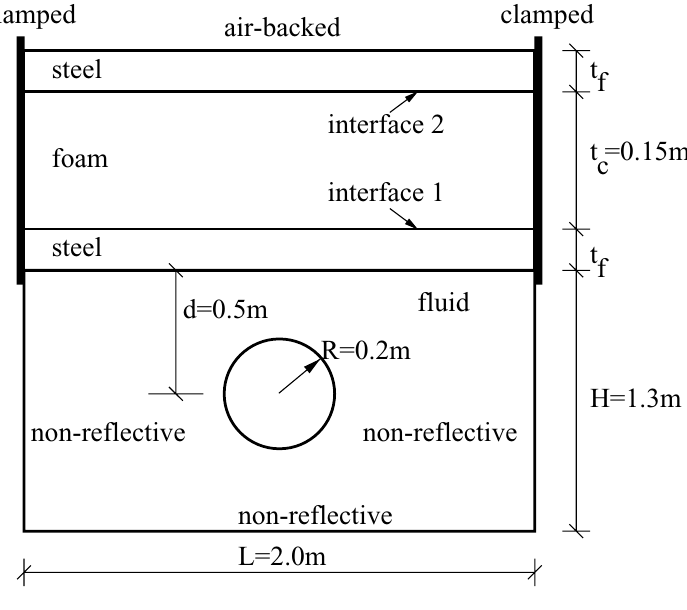
Fig. 1. Schematic drawing for the simulated model